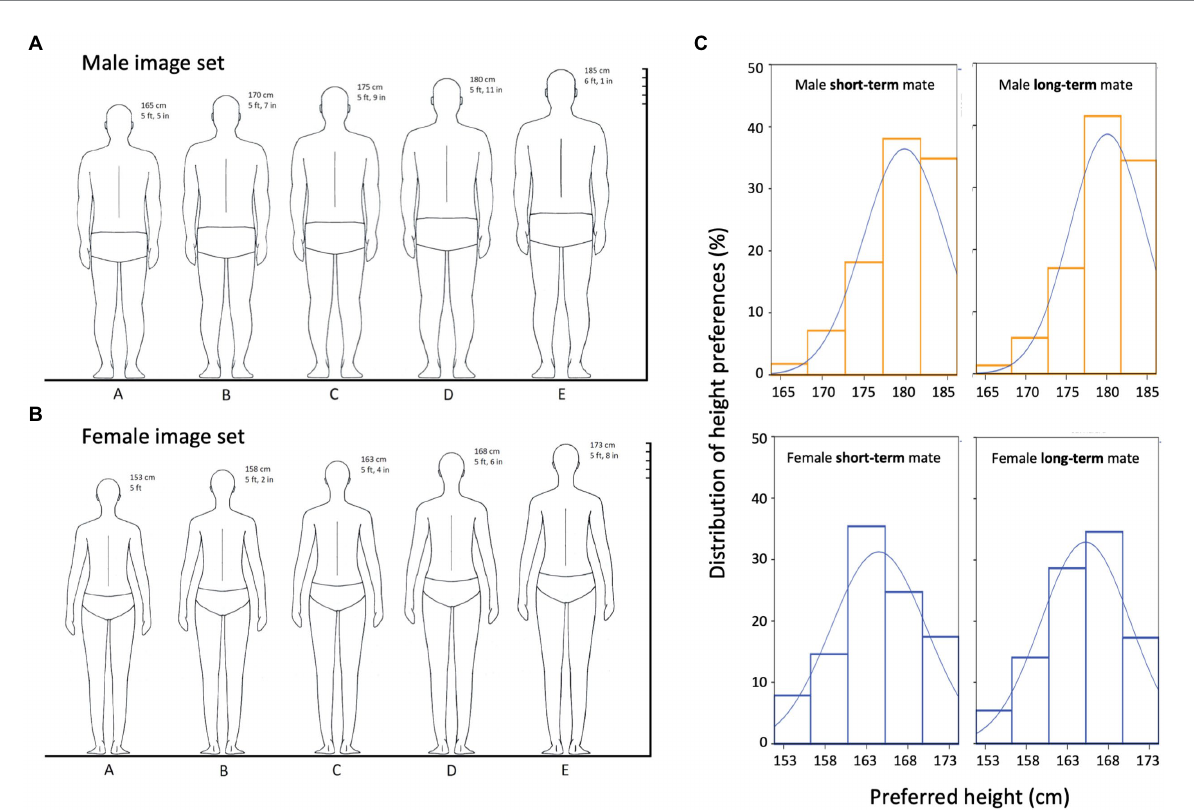
FIGURE 1 (A,B) Stimulus image set featuring back-facing silhouettes of men (panel A ) and women (panel B ) used to measure mate height preferences. See Stimuli for detailed descriptions of stimulus creation and parameters. (C) Distributions of raw absolute height preferences for male heights (top row) and female heights (bottom row) in short-term versus long-term relationship